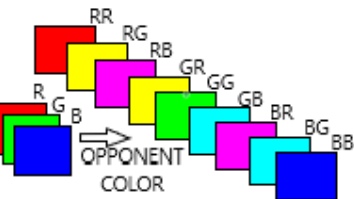
Figure 7. Illustration of color opponent on RGB (Red Green Blue) color space with its 9 opposing color pairs (i.e., RR, RG, RB, GR, GG, GB, BR, BG, BB).